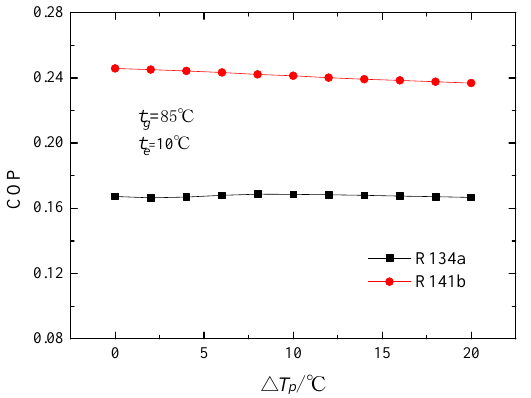
Figure 15. The coefficient of performance COP versus the primary superheating (cid:52) T p